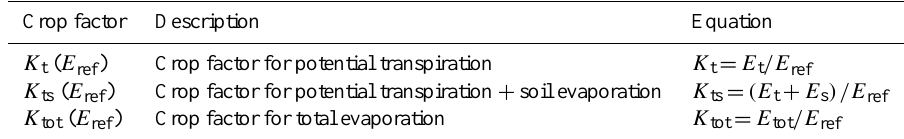
Table 2. Equations used to calculate monthly average crop factors for each vegetation class and E ref method. Crop